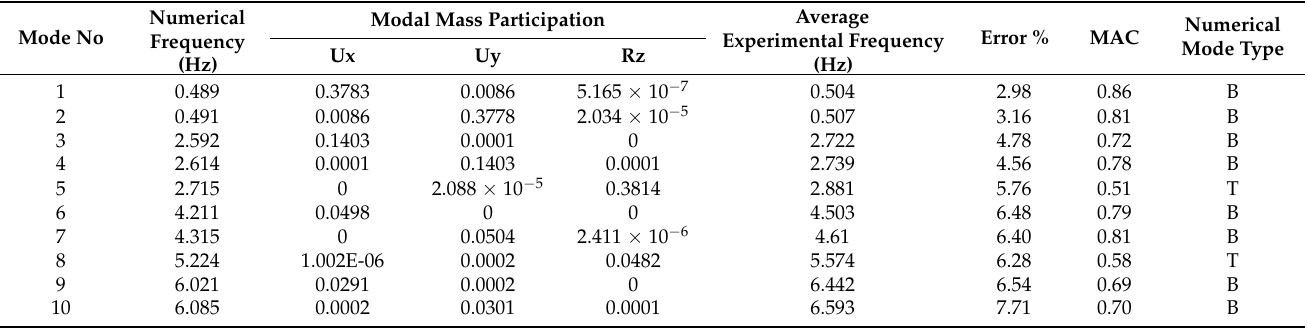
Table 4. Comparison of the experimental and numerical natural